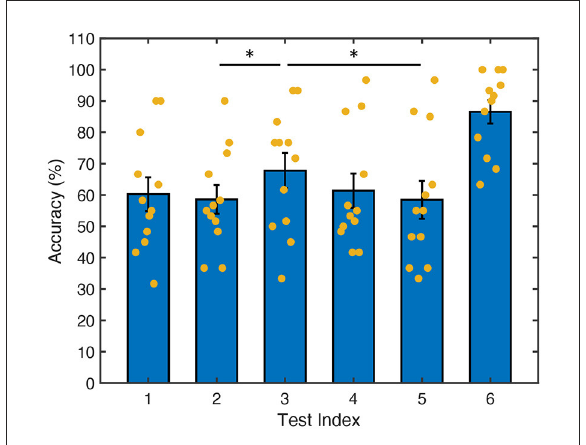
FIGURE6 Accuracy from the six tests in frequency set selection experiment. Heights of the bars represent the mean accuracy, error bars show standard error of the average accuracies from 12 participants, and yellow dots label the average accuracy from each participant. * Indicates significant difference ( p < 0.05, corrected) pair-wise between each two tests with ANOVA. Test